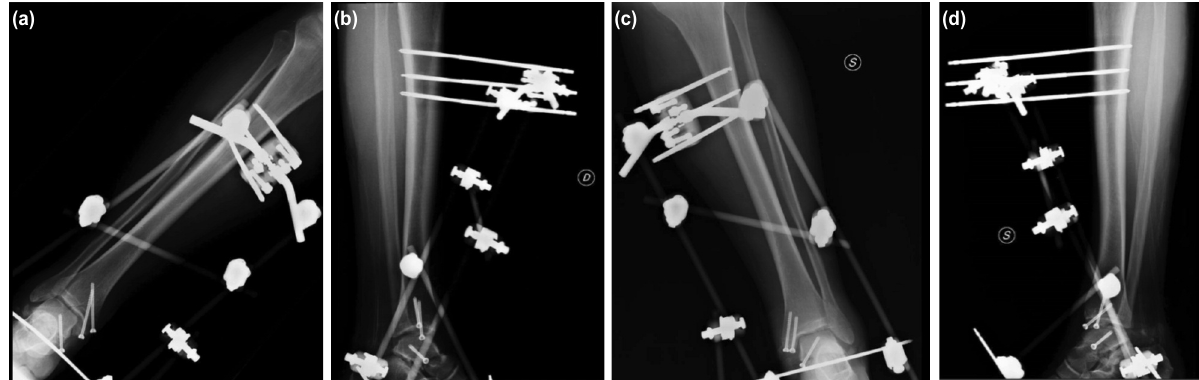
(a), (b), (c) and (d) Post-operative radiograph, show the anatomical reduction of both ankles. Fig. 2: